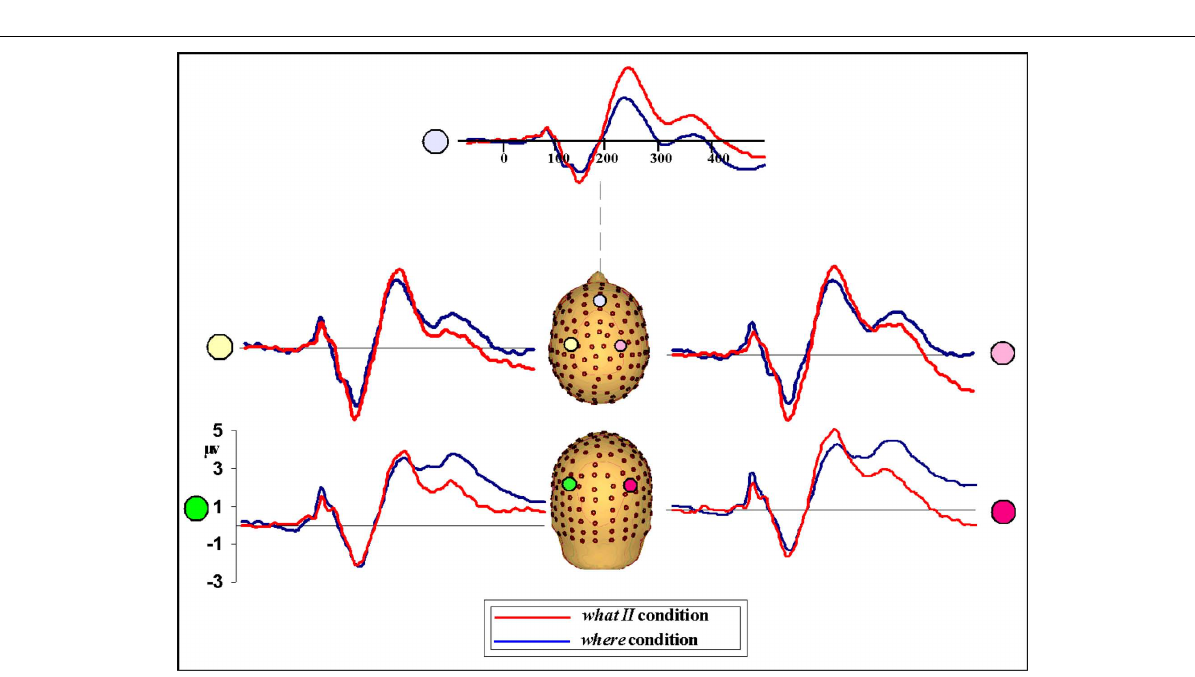
difference between conditions mirrors that seen in WHAT I versus WHERE ; that is, the N1 amplitude for WHAT II is greater than WHERE